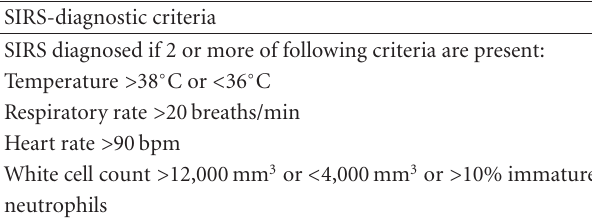
Table 2: The systemic inflammatory response syndrome (SIRS). SIRS-diagnostic criteria SIRS diagnosed if 2 or more of following criteria are